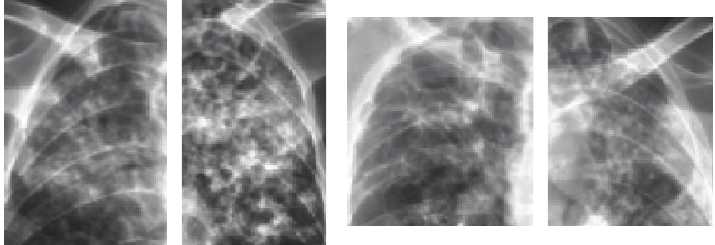
Figure 8: Abnormal lung patches identified by a radiologist.